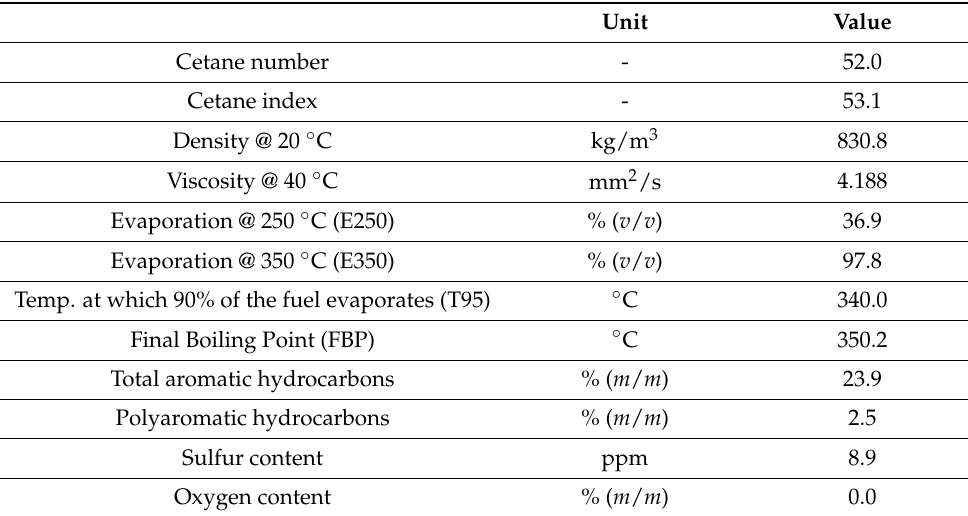
Table 2. Characteristics of conventional diesel fuel used in